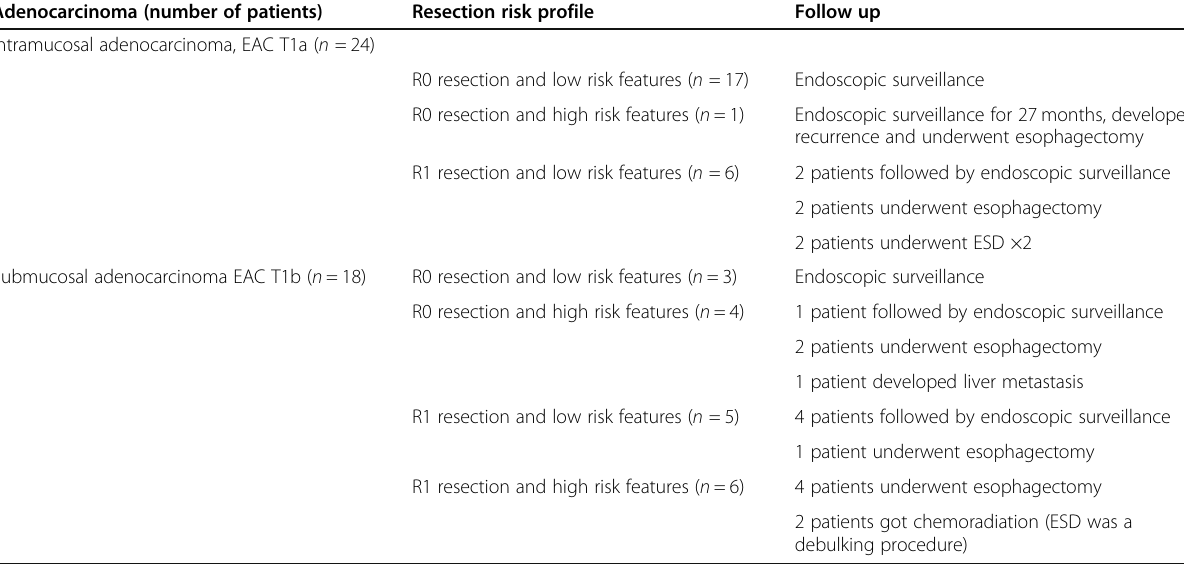
Table 5 Patient follow up Adenocarcinoma (number of patients) Resection risk